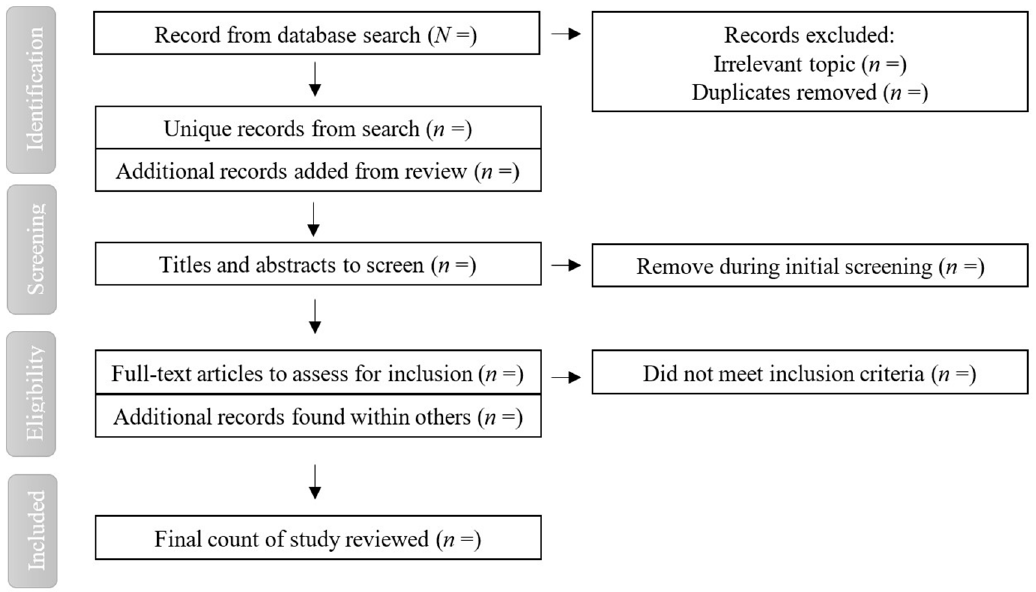
Figure 2. PRISMA flowchart of searching and screening.